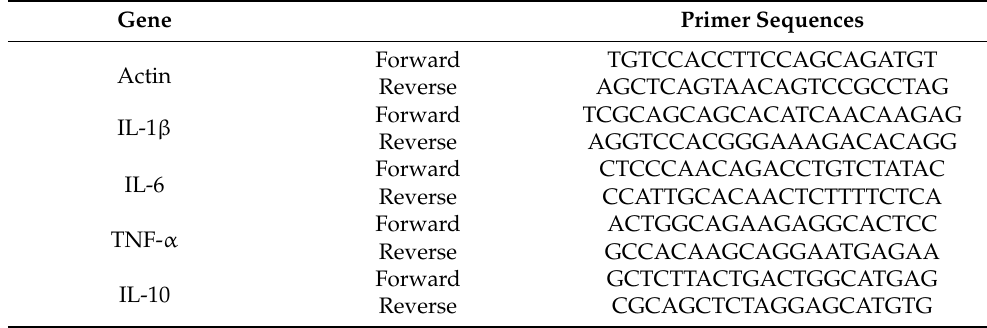
Table 1. Primers of investigated genes in qPCR